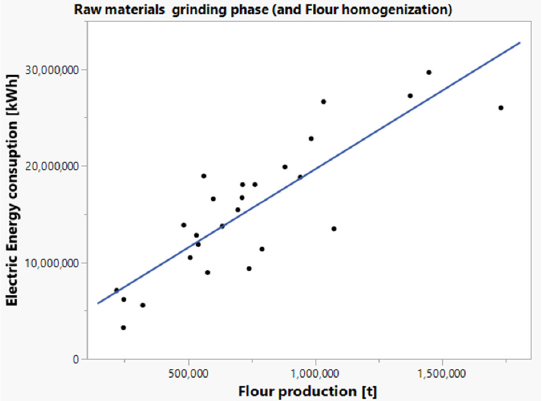
confidence value is 99% for each linear regression.